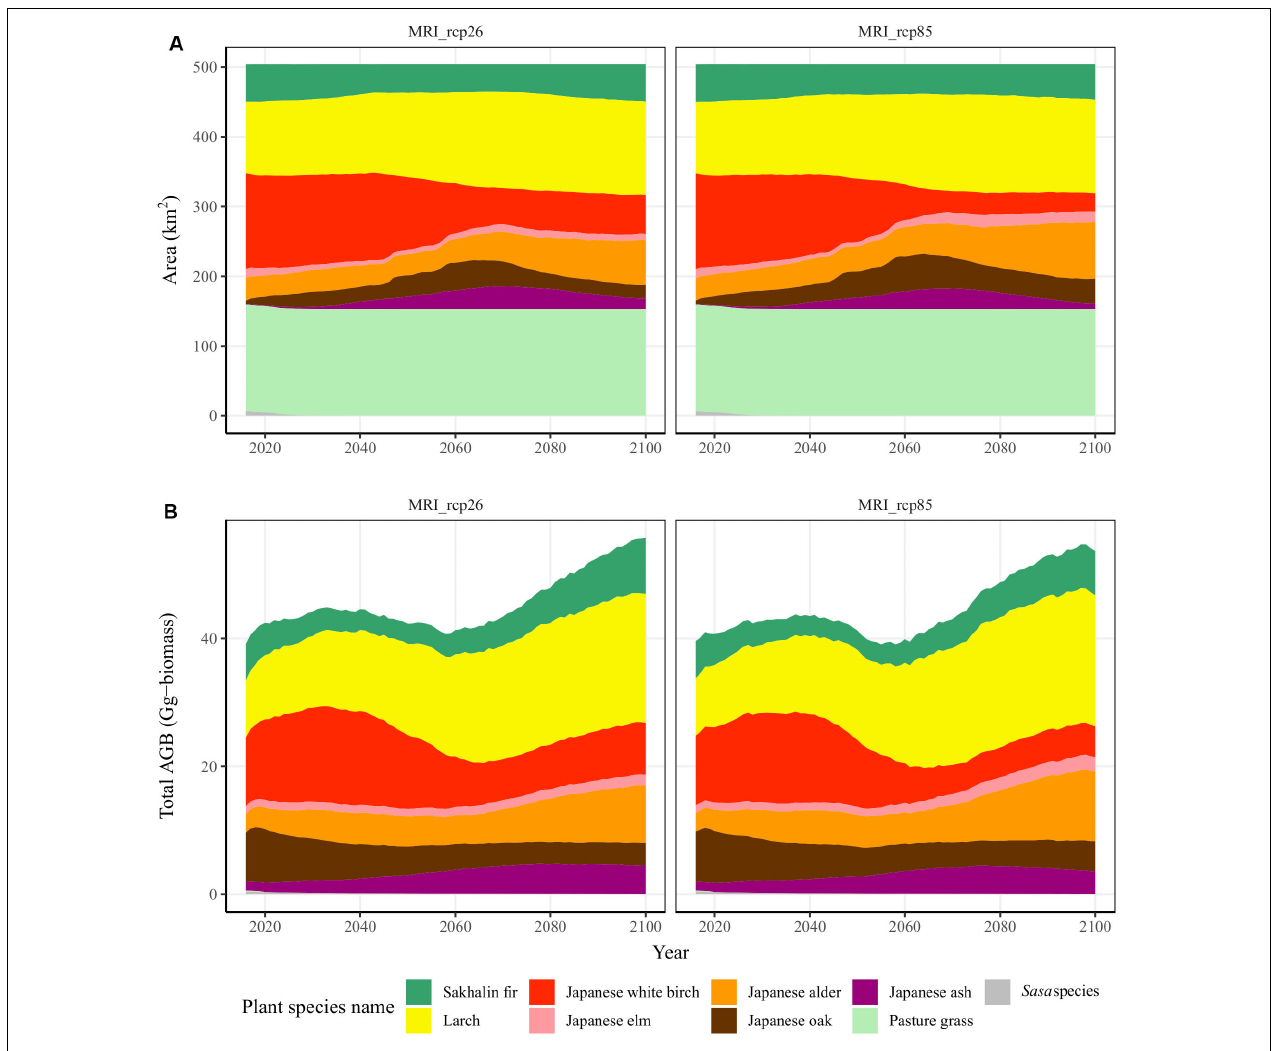
FIGURE 2 | Changes in the (A) land use and land cover and (B) the total aboveground biomass (AGB) for the scenario with no pastureland abandonment expansion (A0) for two climate scenarios (left = IPCC RCP 2.6 and right = IPCC RCP 8.5). The colors indicate the nine plant species simulated in this